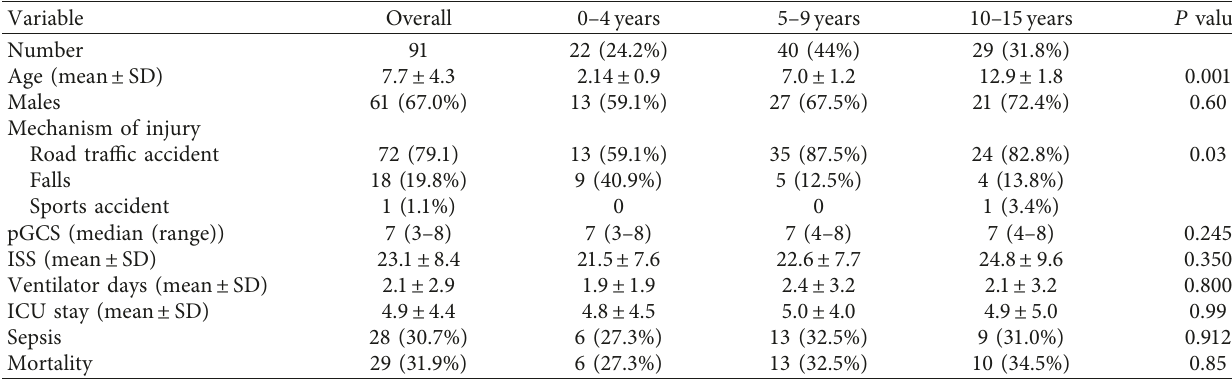
Table 1: Demographics, mechanism of injury, severity of injury, and complications based on age groups among severe pediatric traumatic brain injury patients.